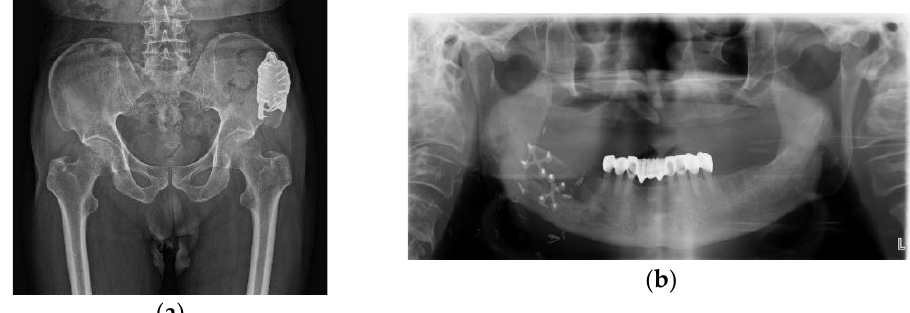
Figure 4. Postoperative radiograph: ( a ) patient-specific implant shown on left iliac bone after 3 months; ( b ) well-reconstructed mandible after 4 months.